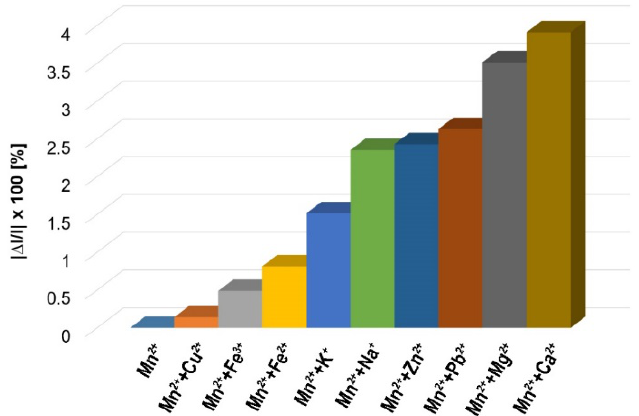
Figure 13. The graphical representation of the average percentage errors produced by several interfering ions in the detection of Mn 2+ .